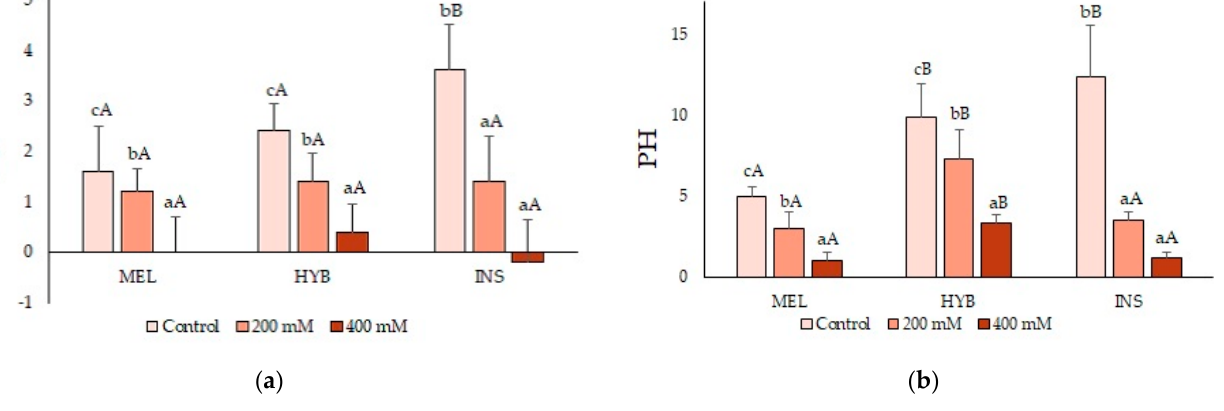
Figure 2. Increase in leaf number (LN) ( a ) and plant height (PH) ( b ) (mean ± SD; n = 5) in Solanum melongena (MEL), Solanum insanum (INS) and their hybrid (HYB) in comparison with the beginning of the salt treatment (control, 200 and 400 mM of NaCl, as indicated). Different lowercase letters within the same genotype indicate statistically significant differences between treatments, and different uppercase letters within the same treatment indicate statistically significant differences between genotypes ( p < 0.05), according to the Student–Newman–Keuls multiple range test.